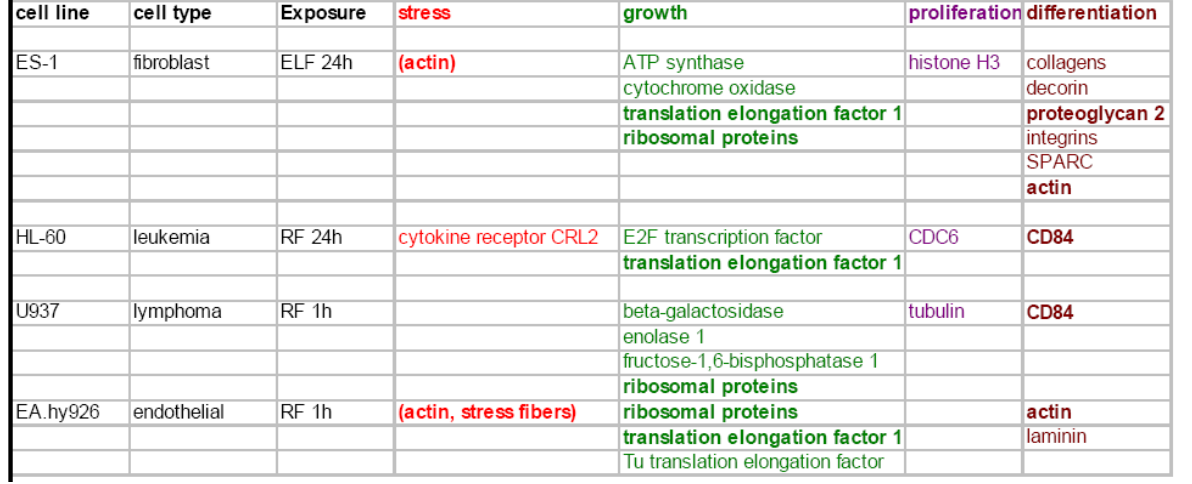
Figure 2. Summary of genes regulated as a consequence of cell exposure to radio- frequency (RF) and extremely low frequency (ELF) electromagnetic field*. (From [29], reproduced by the kind permission of Dr. Maercker). * Presented results derived from comparative gene expression studies and are not proven in alternative assays